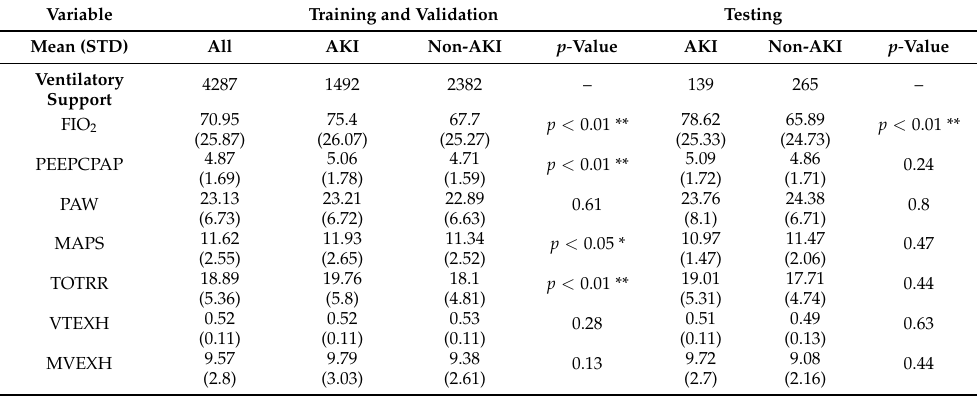
Table 7. Cohort Analysis of Ventilatory